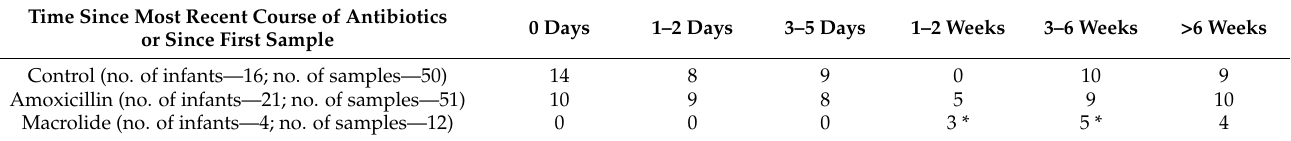
Table 1. Number of infants stratified by control, amoxicillin and macrolide divided into time since